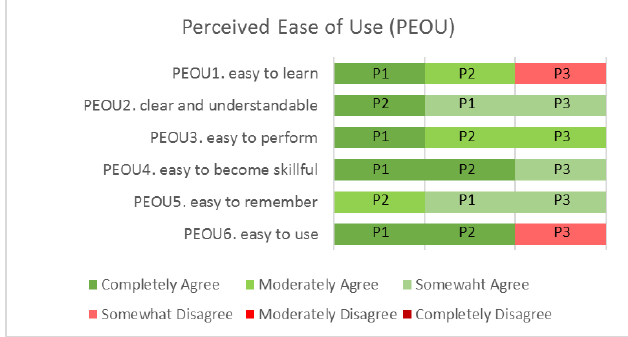
Fig 4. Perceived ease of use from the point of view of the participants.